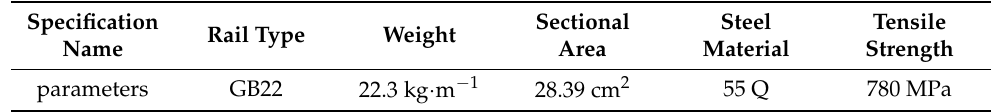
Table 1. Specification of anti-slip pile.